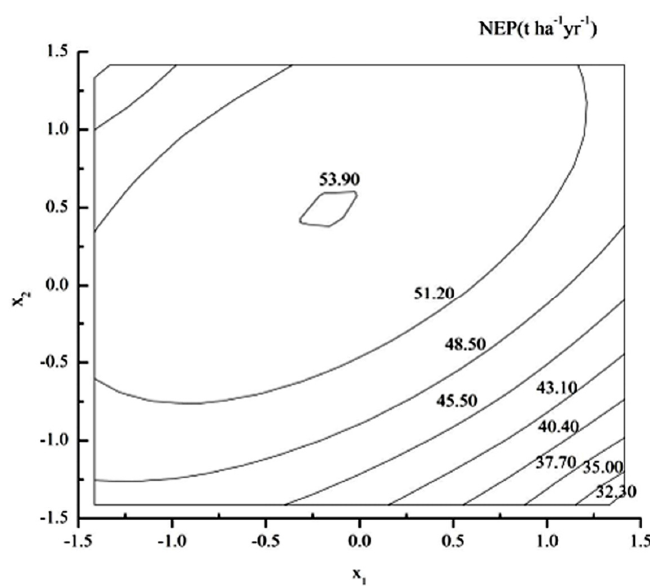
Figure 4. Single effect of selective thinning intensity or thinning residual removal rate on net ecosystem productivity (NEP). x is controlled factor selective thinning intensity or thinning residual removal rate. NEP1 and NEP 2 are effects of selective thinning intensity and thinning residual removal rate on NEP respectively.